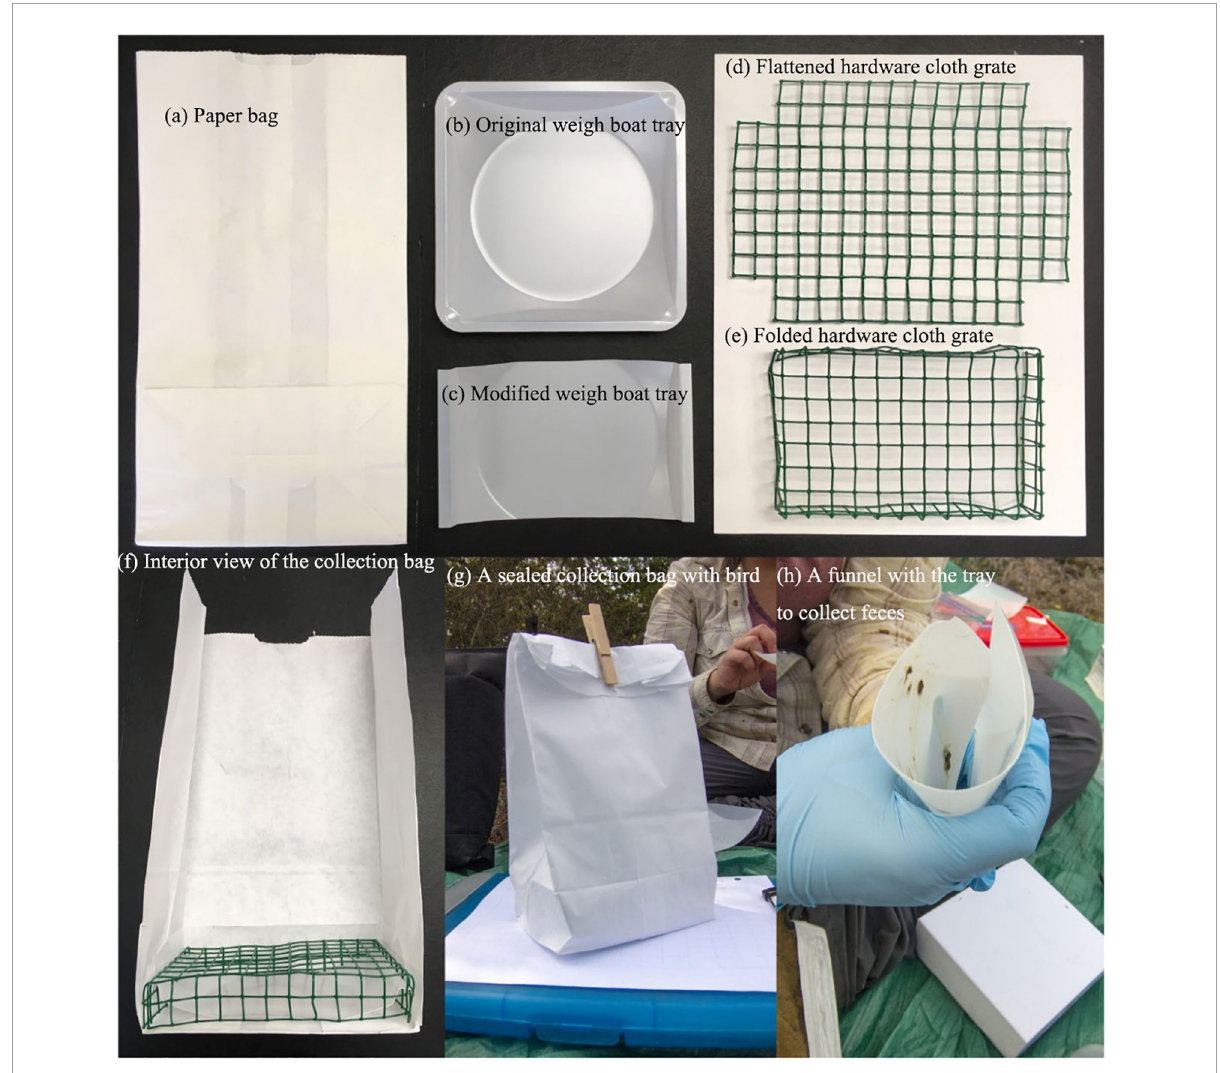
FIGURE4 Schematic diagram for the non-invasive sample of feces using the collection kit [Reprinted from Knutie and Gotanda